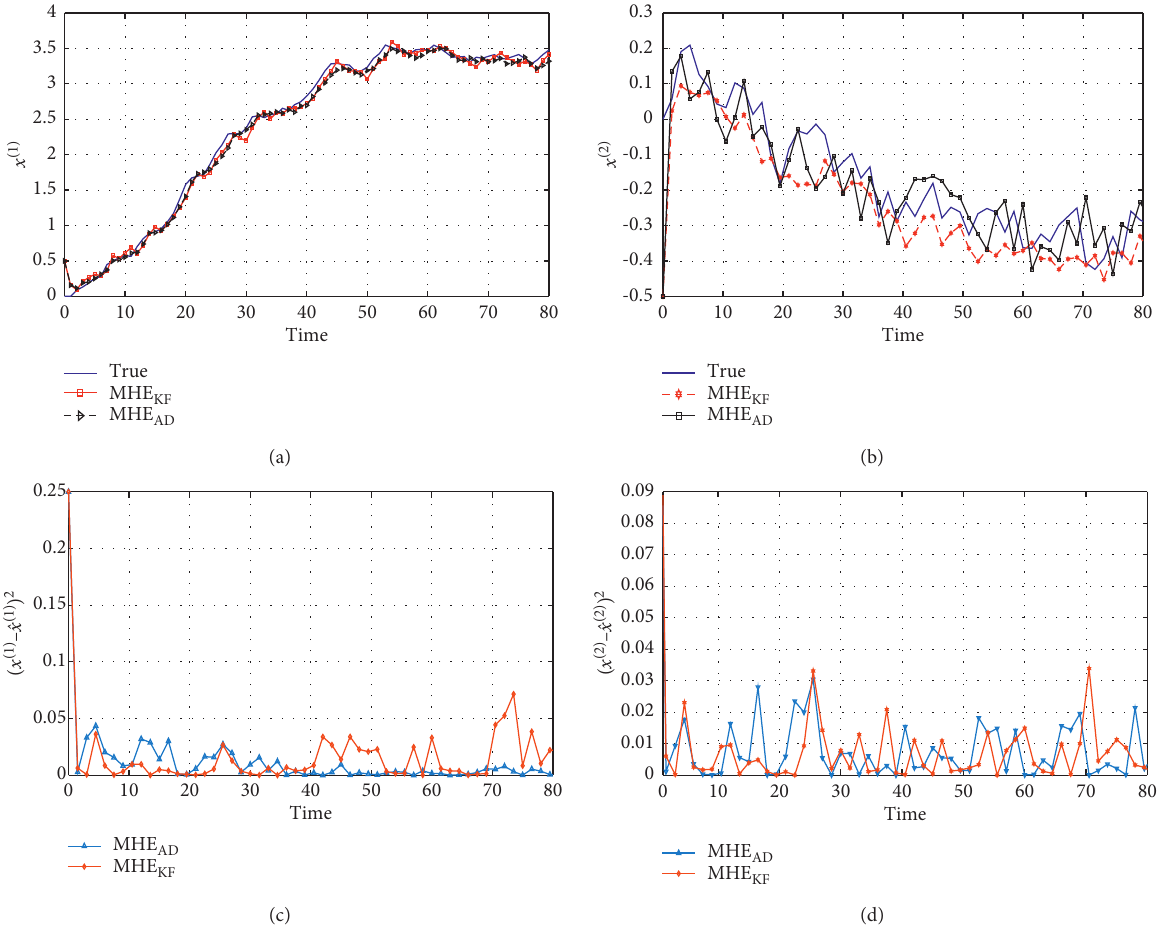
Figure 1: Comparison of estimators for model (20) with horizon length N � 10. (a) Estimation of x ( 1 ) . (b) Estimation of x ( 2 ) .